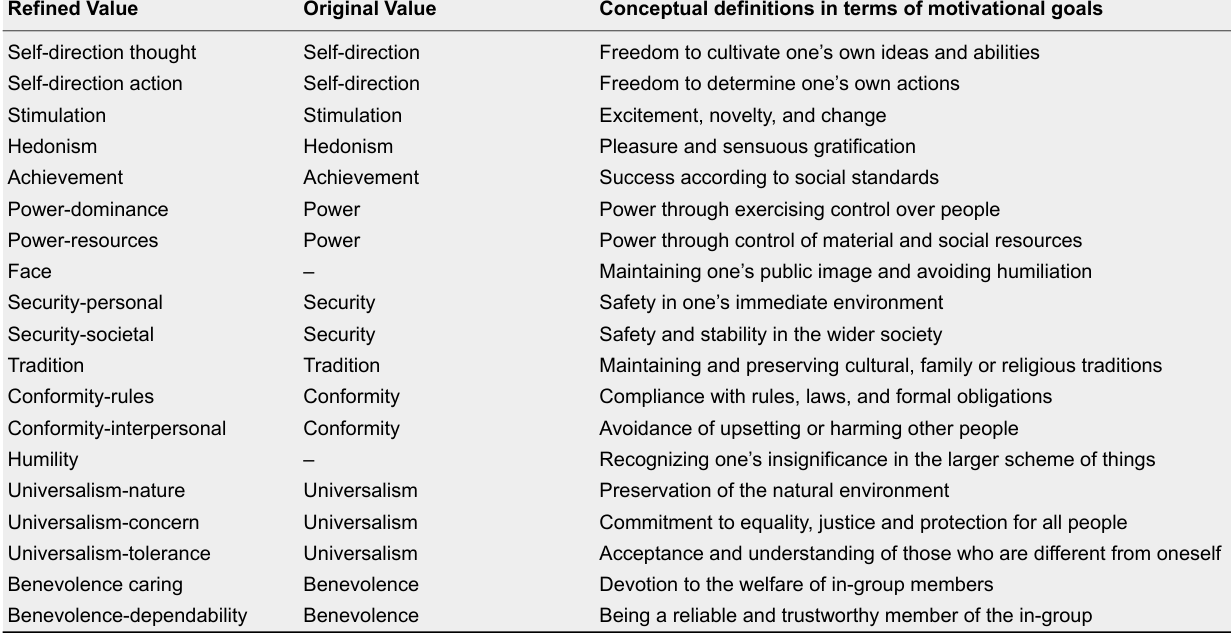
Conceptual definitions in terms of motivational goalsOriginal ValueRefined